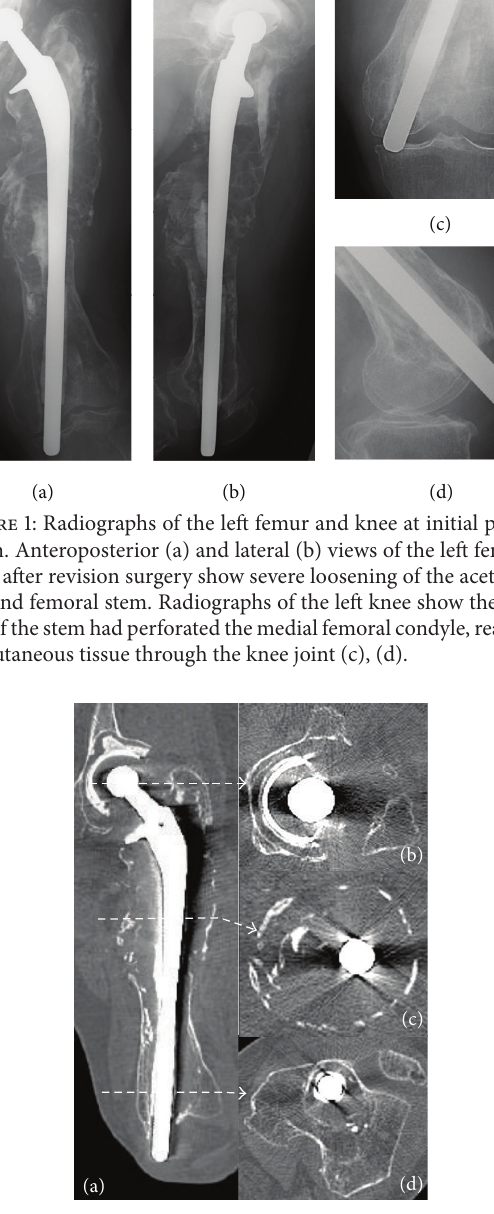
Figure 2: Computed tomography (CT) images of the left femur. Coronal CT image of the left femur shows a massive osteolytic lesion involving two-thirds of the proximal femur with thin cortical fragments surrounding the stem (a). Most of the cement mantle has disappeared except around the greater trochanter and middle of the stem. Axial views from the dotted lines are noted (b)–(d).